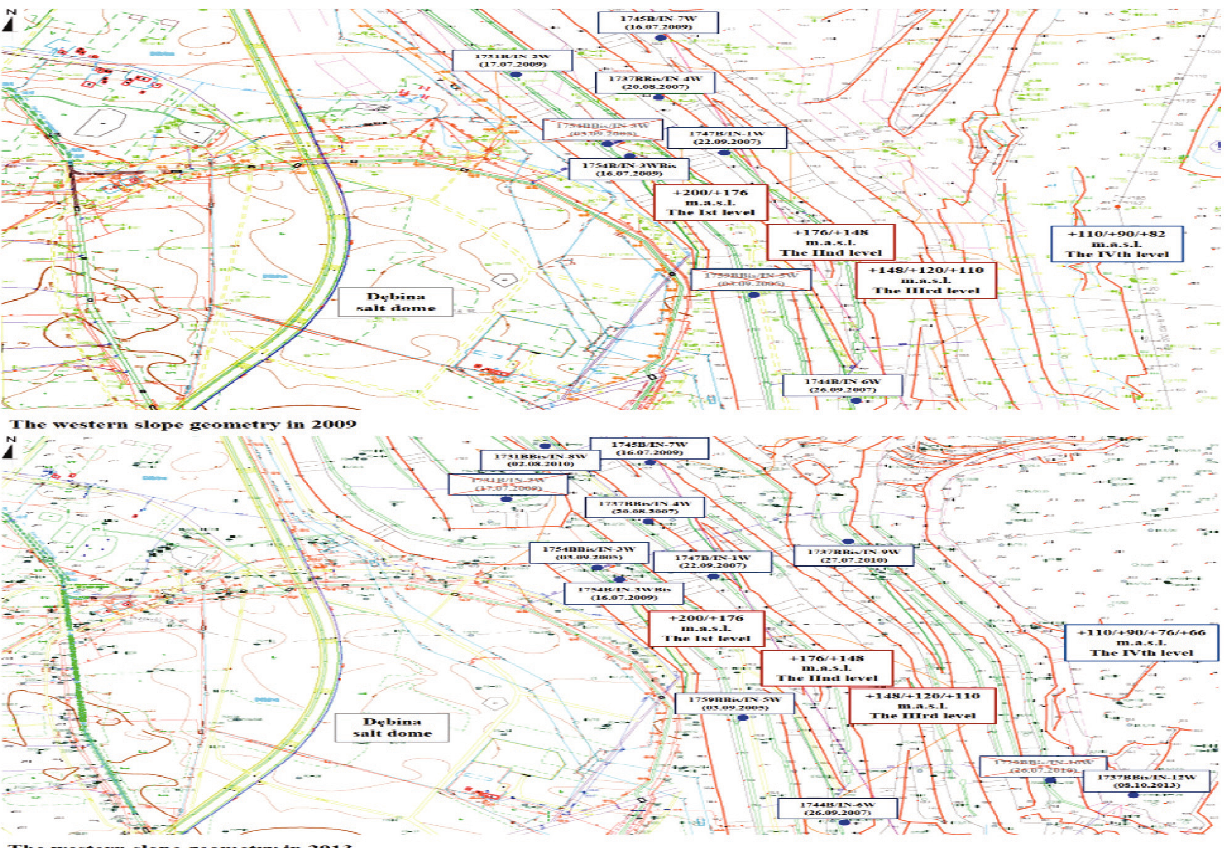
Fig. 10. The exploitation progress and western slope geometry changes between 2009 and 2013 (based on